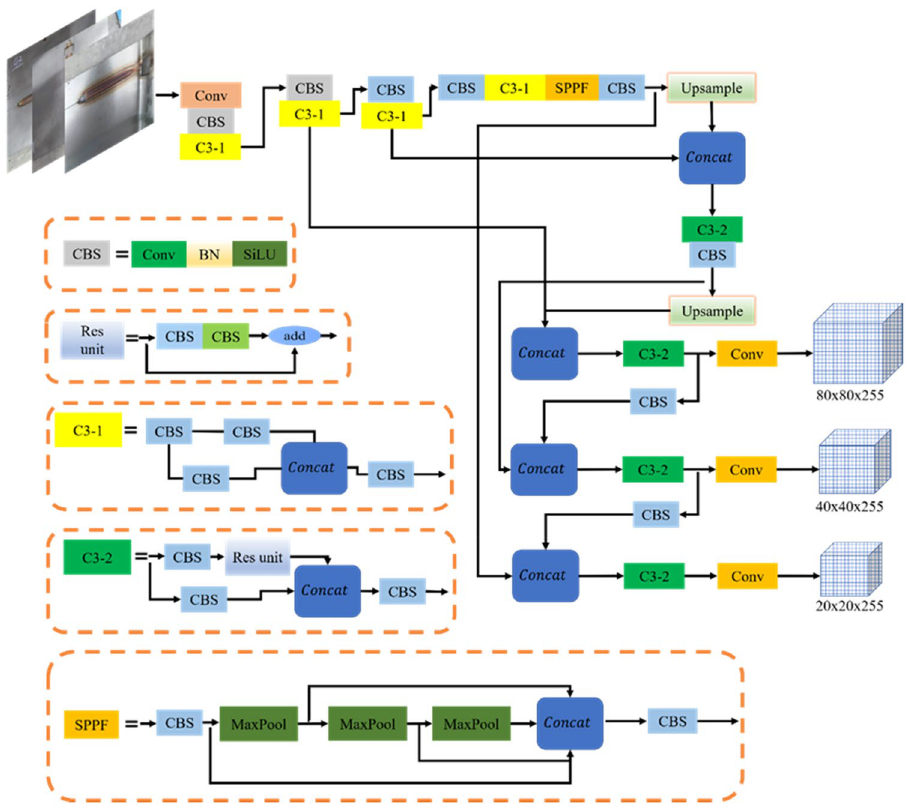
Figure 6. YOLOv5 network